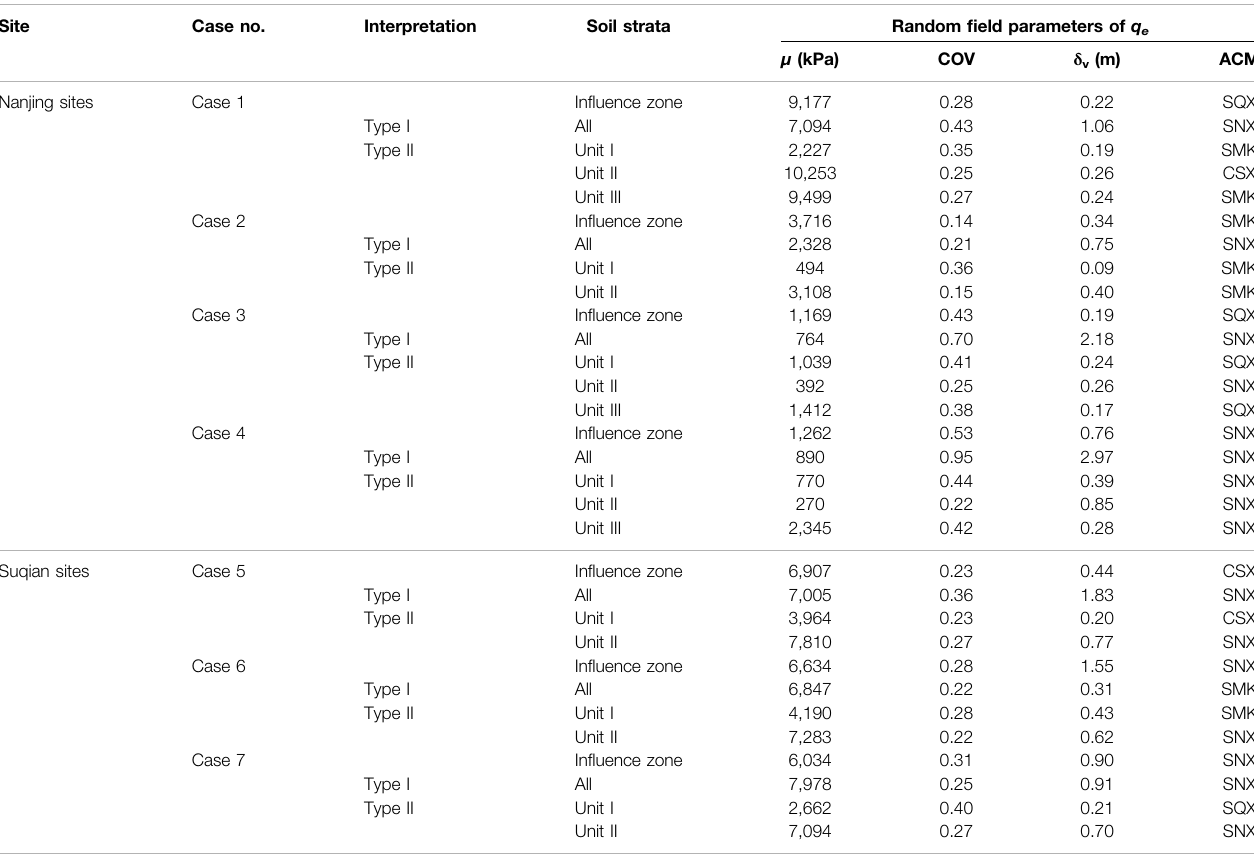
TABLE 5 | The results of spatial analysis of q e . Site Case